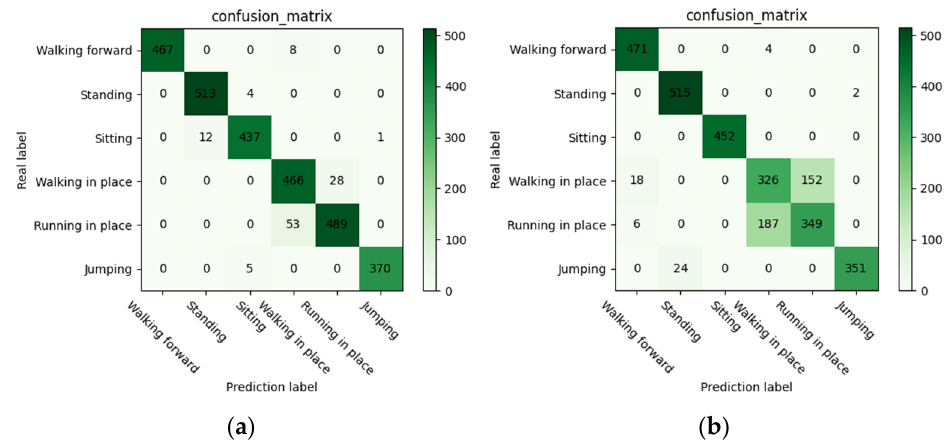
Figure 8. Confusion matrix obtained for inertial sensors ( a ) and stretch sensors ( b ) on the IS-Data dataset.